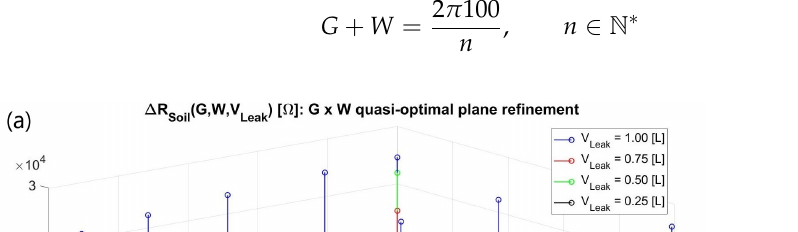
Figure 4. ( a ) Three-dimensional discrete function Δ R Soil (G, W, V Leak ): ℝ 3 → ℝ elucidating the